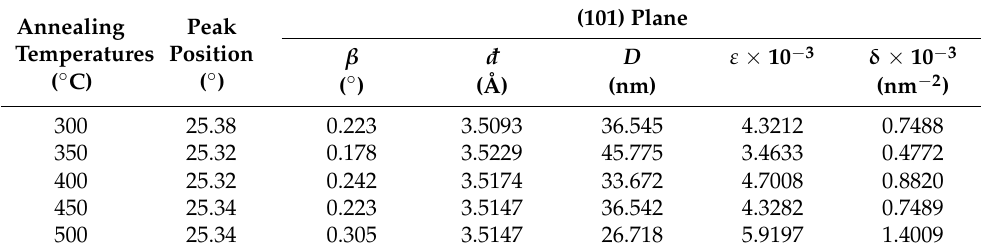
Table 2. The XRD results of the 7.5 wt%-injected TiO 2 annealed at different temperatures from 300 to 500 ◦